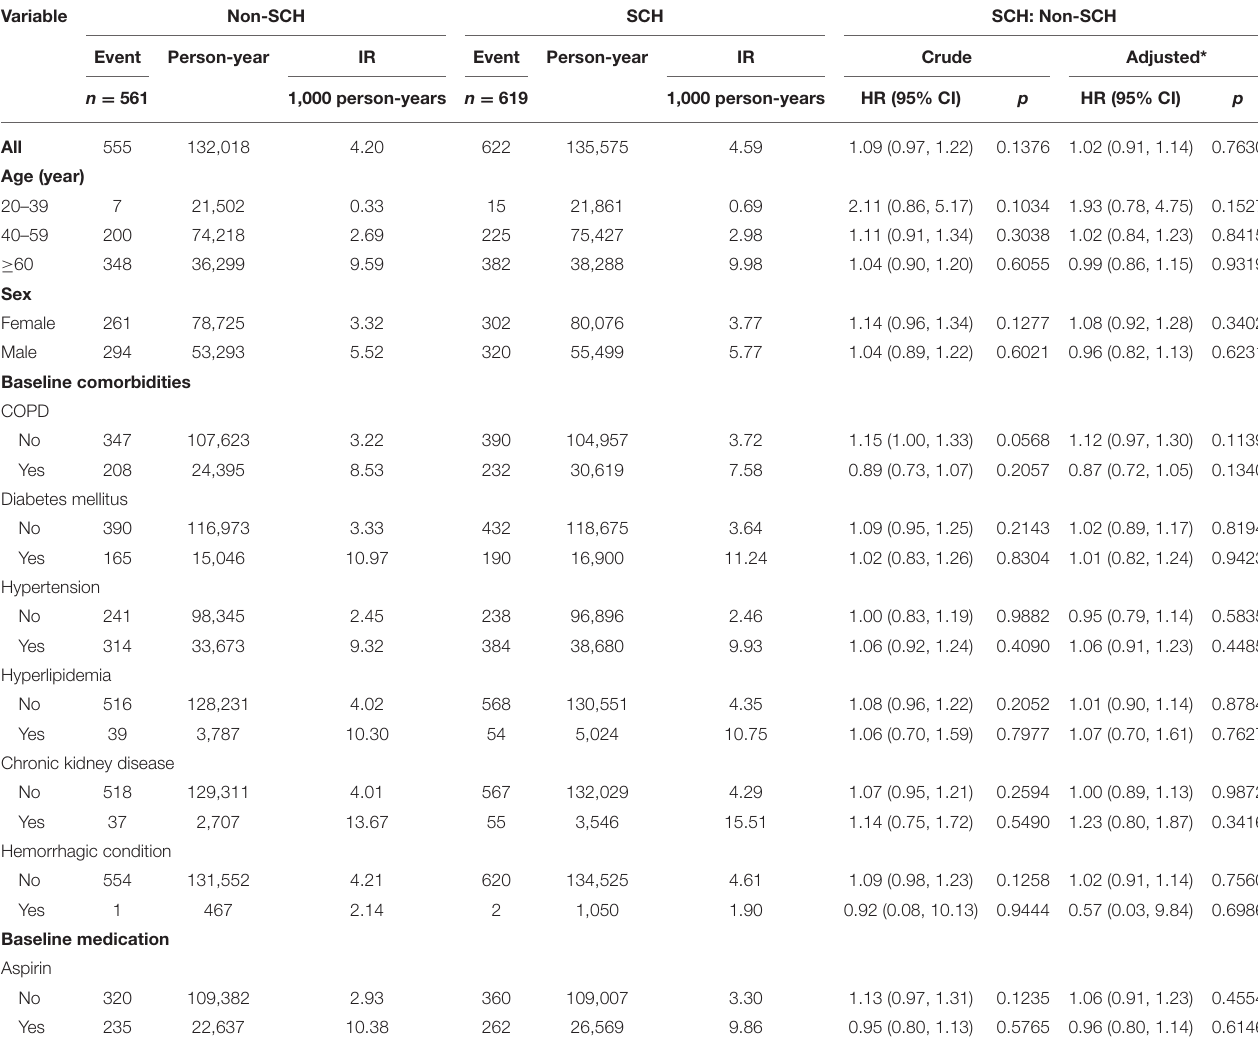
TABLE 3 | Comparison of incidence of acute coronary syndrome between patients with and without SCH in different stratifications. Variable Non-SCH SCH SCH: